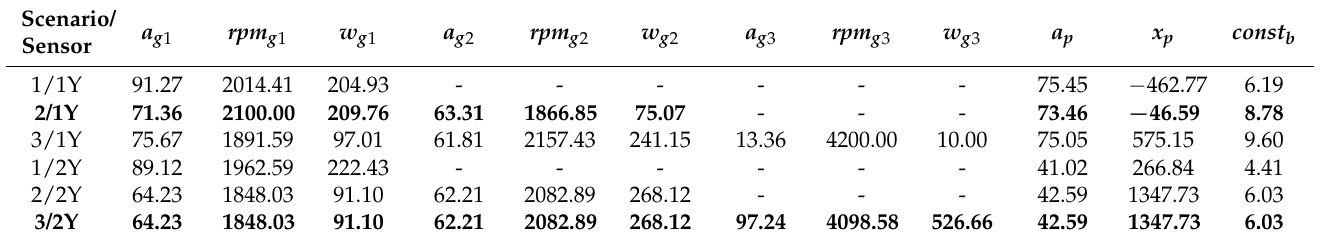
Table 4. Parameters of the decomposed functions identified by the DE algorithm and chosen by the MD3 method based on the imbalance data and the MSE as the quality index.